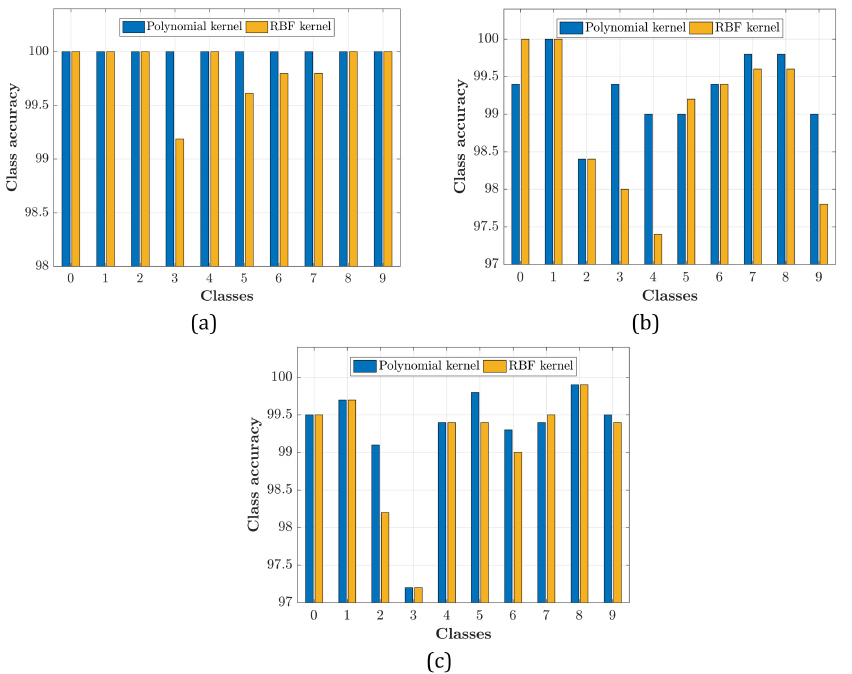
Figure 5. Comparison of classes accuracy using polynomial and RBF kernels for ( a ) Roman, ( b ) Arabic, and ( c ) Devanagari.